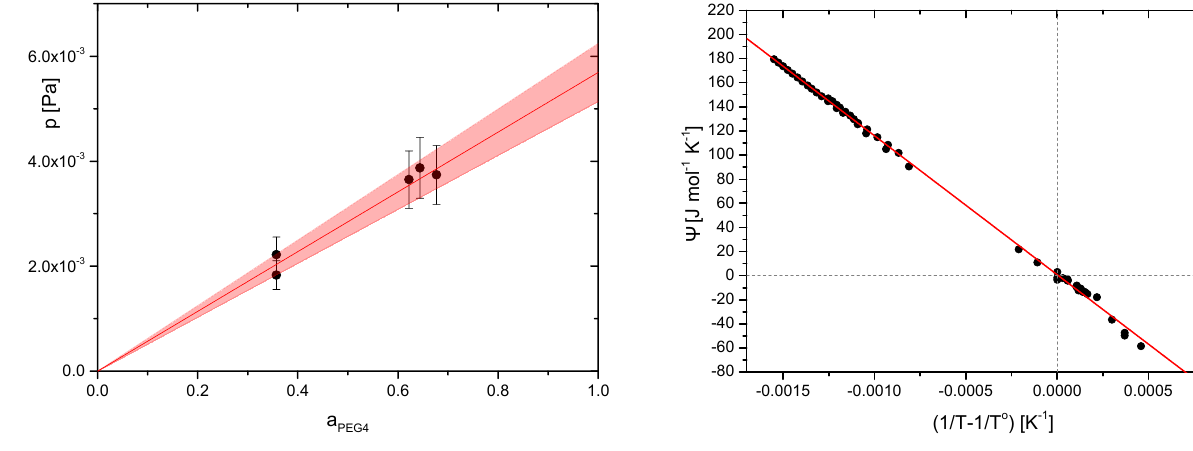
(cid:16) (cid:17) T (cid:9) Figure B1. (cid:57) vs. inverse, 1 /T − 1 . Filled circles: all PEG3 / data but Wise et al. (1950); red line: linear